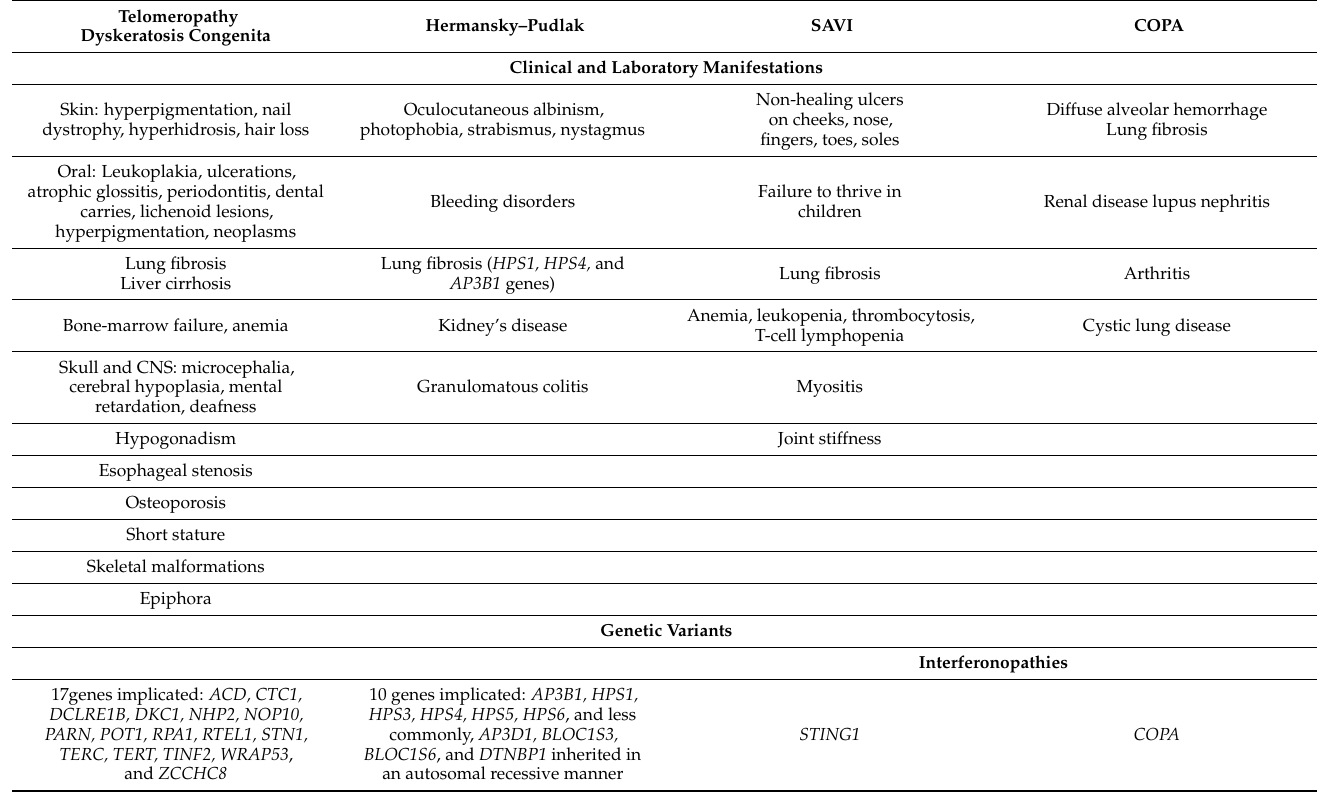
Table 1. Syndromic forms of pulmonary